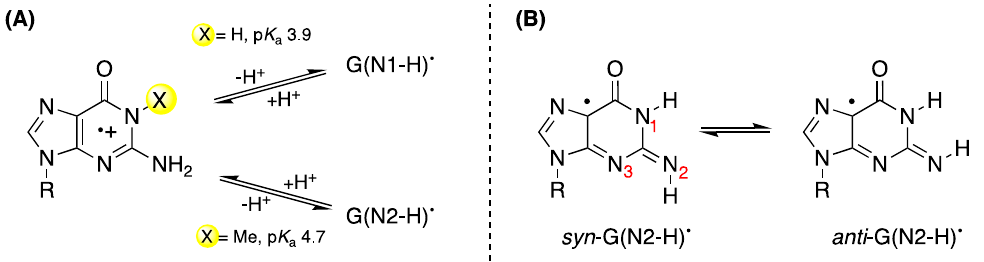
Figure 2. ( A ) The deprotonation of G •+ (X = H) and 1-Me-G •+ (X = Me) affording G(N1-H) • and G(N2-H) • , respectively. ( B ) Conformational isomers of G(N2-H) • in syn and anti with respect to N3 atom; the earlier syn - and anti -conformations were defined with respect to N1-H [11] and, as syn and anti with respect to N3 have been commonly used in the recent literature, these notations are adopted in the text.